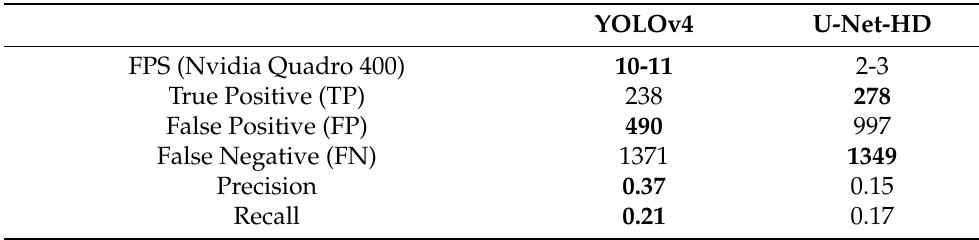
Table 2. Performance comparison between YOLOv4 and U-Net with Hausdorff distance (U-Net-HD) for aphid detection. Values in bold indicate the best results for each criterion.